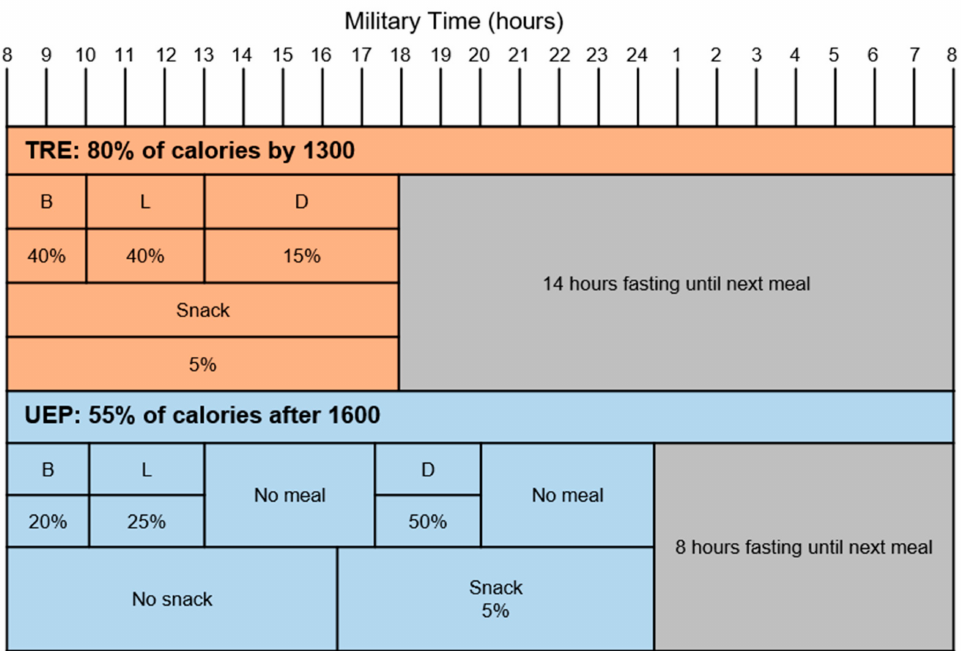
Figure 2. Eating windows and distribution of calories throughout the day. In the TRE arm, partici- pants consumed all calories between 0800 and 1800 and fasted for 14 h beginning at 1800; participants consumed 40%, 40%, and 15% of total daily calories at breakfast, lunch and dinner, respectively. In the UEP arm, participants consumed all calories between 0800 and 0000 and fasted for 8 h beginning at 2000; participants consumed 20%, 25%, and 50% of total calories at breakfast, lunch, and dinner,